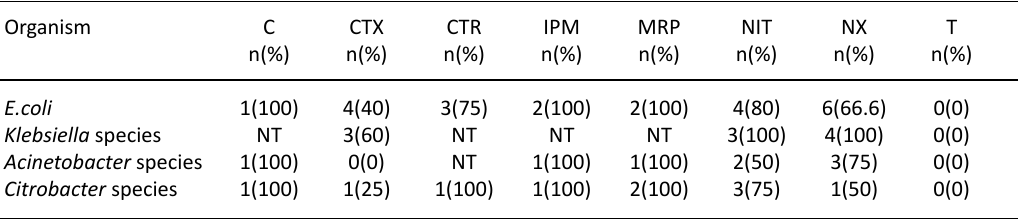
Table 5. Antibacterial Susceptibility pattern for miscellaneous antibiotics against Enterobacteriaceae members isolated from infertility